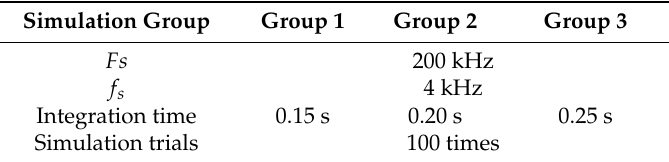
Table 2. Processing parameters for tracking threshold simulation evaluation.